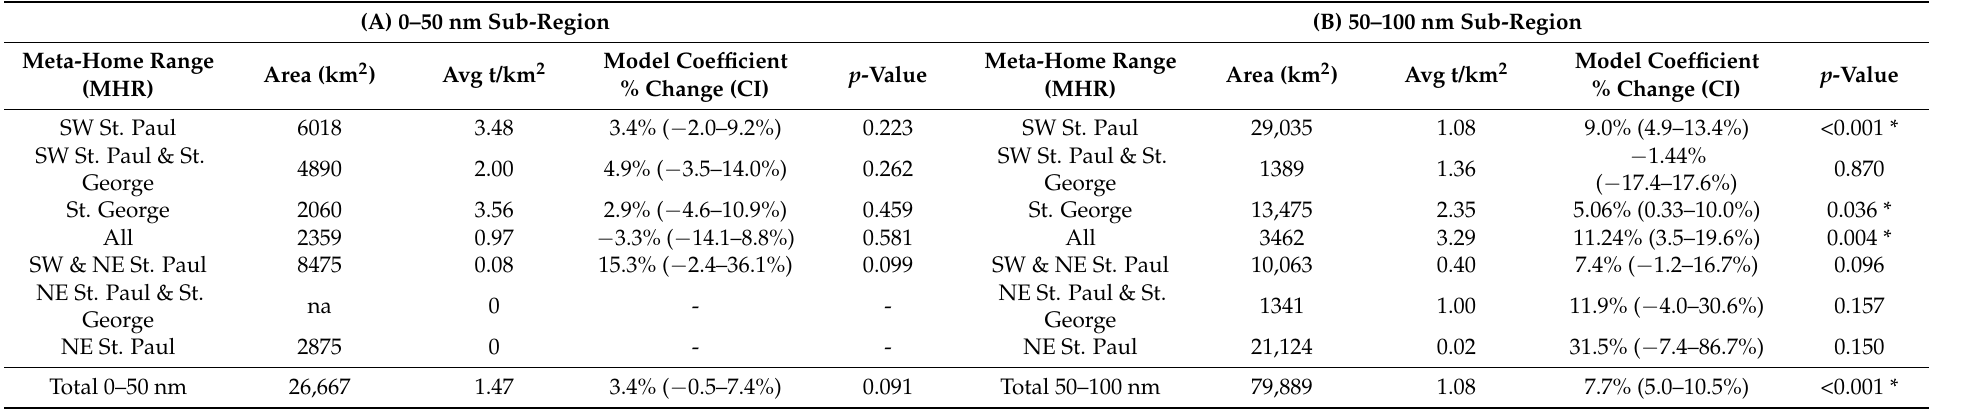
Table 2. Area (km 2 ) that encompasses each meta-home range (MHR) and harvest intensity (average annual tons (Avg t) pollock harvested per km 2 ) for: ( A ) 0–50